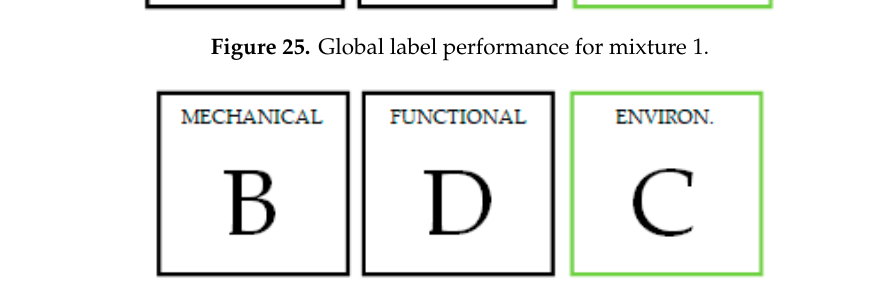
Figure 26. Global label performance for mixture 2.